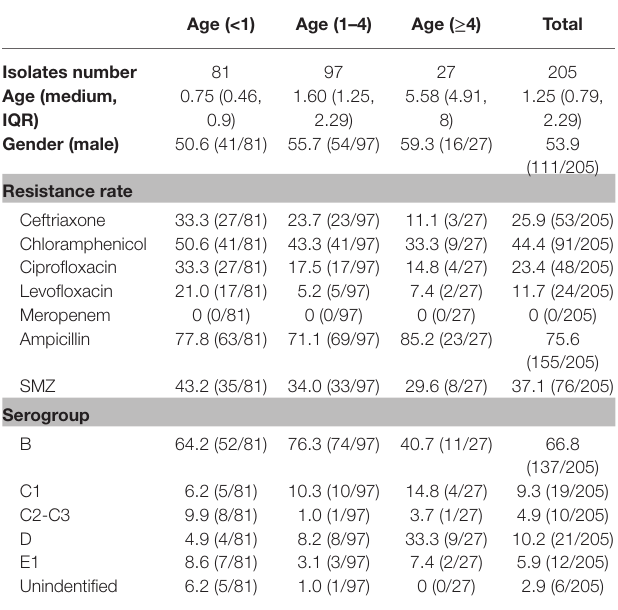
TABLE 1 | The clinical information, serogroup and antibiotic resistance rate of 205 Salmonella